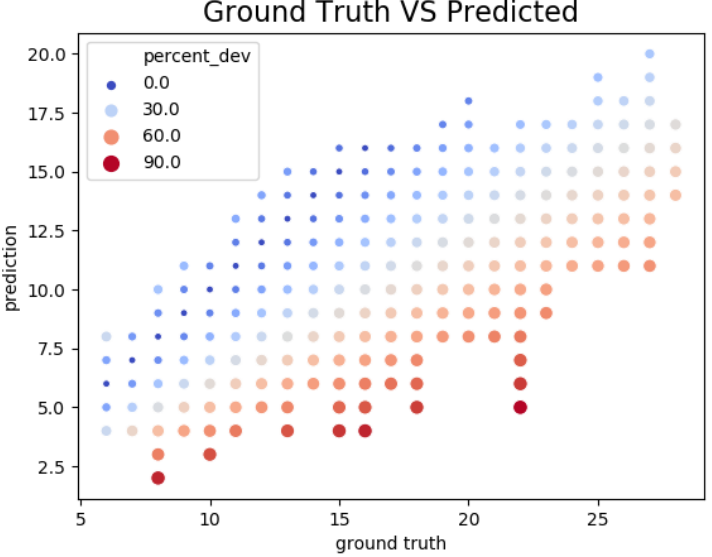
Figure 12. Number of ground truth detection against the number of detection. We observe that the relationship is linear, meaning that the algorithm manages to capture